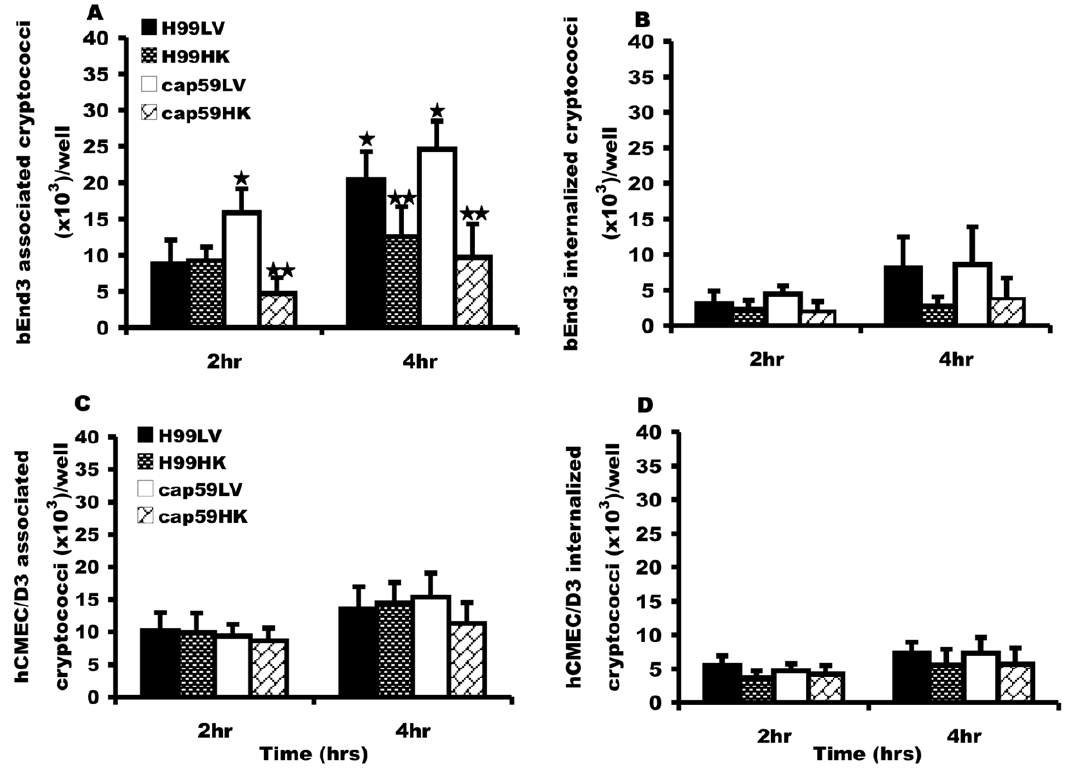
Figure 5. Effect of viability on binding and phagocytosis of H99 and cap59 strains by BMEC. Heating for 15 min at 65 u C prior to infection killed H99 and cap59 cryptococci. Brain microvascular cells (BMEC), bEnd3 and or hCMEC/D3 cells were exposed in parallel to live (LV) and heat-killed (HK) cryptococci for 2 hr and 4 hr at 37 u C and the number of bound and internalized cryptococci was determined by fluorescence microscopy. (A and C) Association efficiency of live and heat-killed H99 or cap59 cryptococci by bEnd3 and hCMEC/D3 cell respectively. There was no difference in association of viable H99 and cap59 cryptococci with hCMEC/D3 cells at either time point, P . 0.05. However, viable cryptococci were more associated than non-viable ones by 4 hr of incubation in bEnd3 cells, P , 0.01 for both H99 and cap59 respectively. (B and D) Internalization efficiency of LV and HK H99 and cap59 cryptococci by bEnd3 and hCMEC/D3 cells. Both live and heat-killed cryptococci showed a time dependent increase in phagocytosis by both bEnd3 and hCMEC/D3 cells, however the rate of phagocytosis did not vary between the viable and non-viable cryptococci in both cell-lines, P . 0.05 at both 2 hr and 4 hr of incubation. Error bars are standard error of the mean, n=5 repeats.